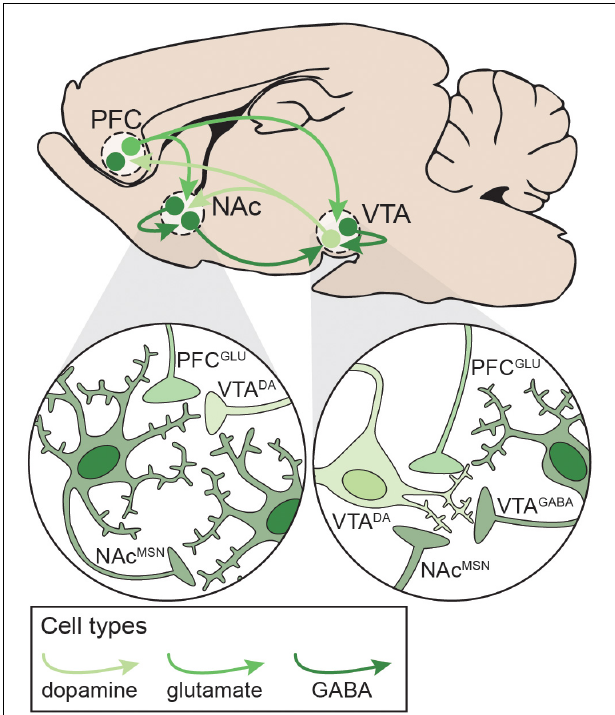
FIGURE 3 | Neural circuitry targeted by potentially addictive drugs. Simplified schematic emphasizing local and distal connections between the PFC, NAc, and VTA that are targeted by potentially addictive drugs. Left : NAc MSNs receive excitatory glutamatergic inputs from PFC GLU neurons, dopaminergic inputs from VTA DA neurons, and inhibitory GABAergic inputs from other NAc MSNs . Right : VTA DA neurons are maintained under tonic inhibition by local VTA GABA interneurons and NAc MSNs and receive excitatory inputs from PFC GLU neurons. DA: dopamine; GLU: glutamate; MSN: medium spiny neuron; NAc: nucleus accumbens; PFC: prefrontal cortex; VTA: ventral tegmental